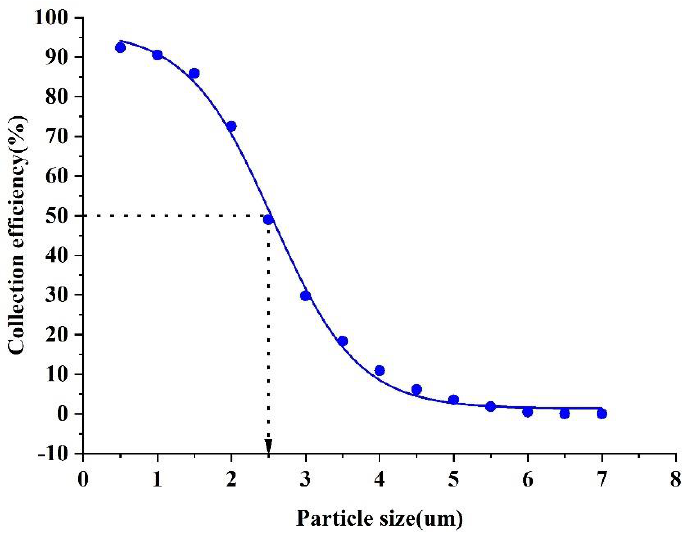
Figure 13. New ultra − low temperature virtual impactor collection efficiency curve. Table 3. Comparison with other methods of decreasing cut− off diameter.